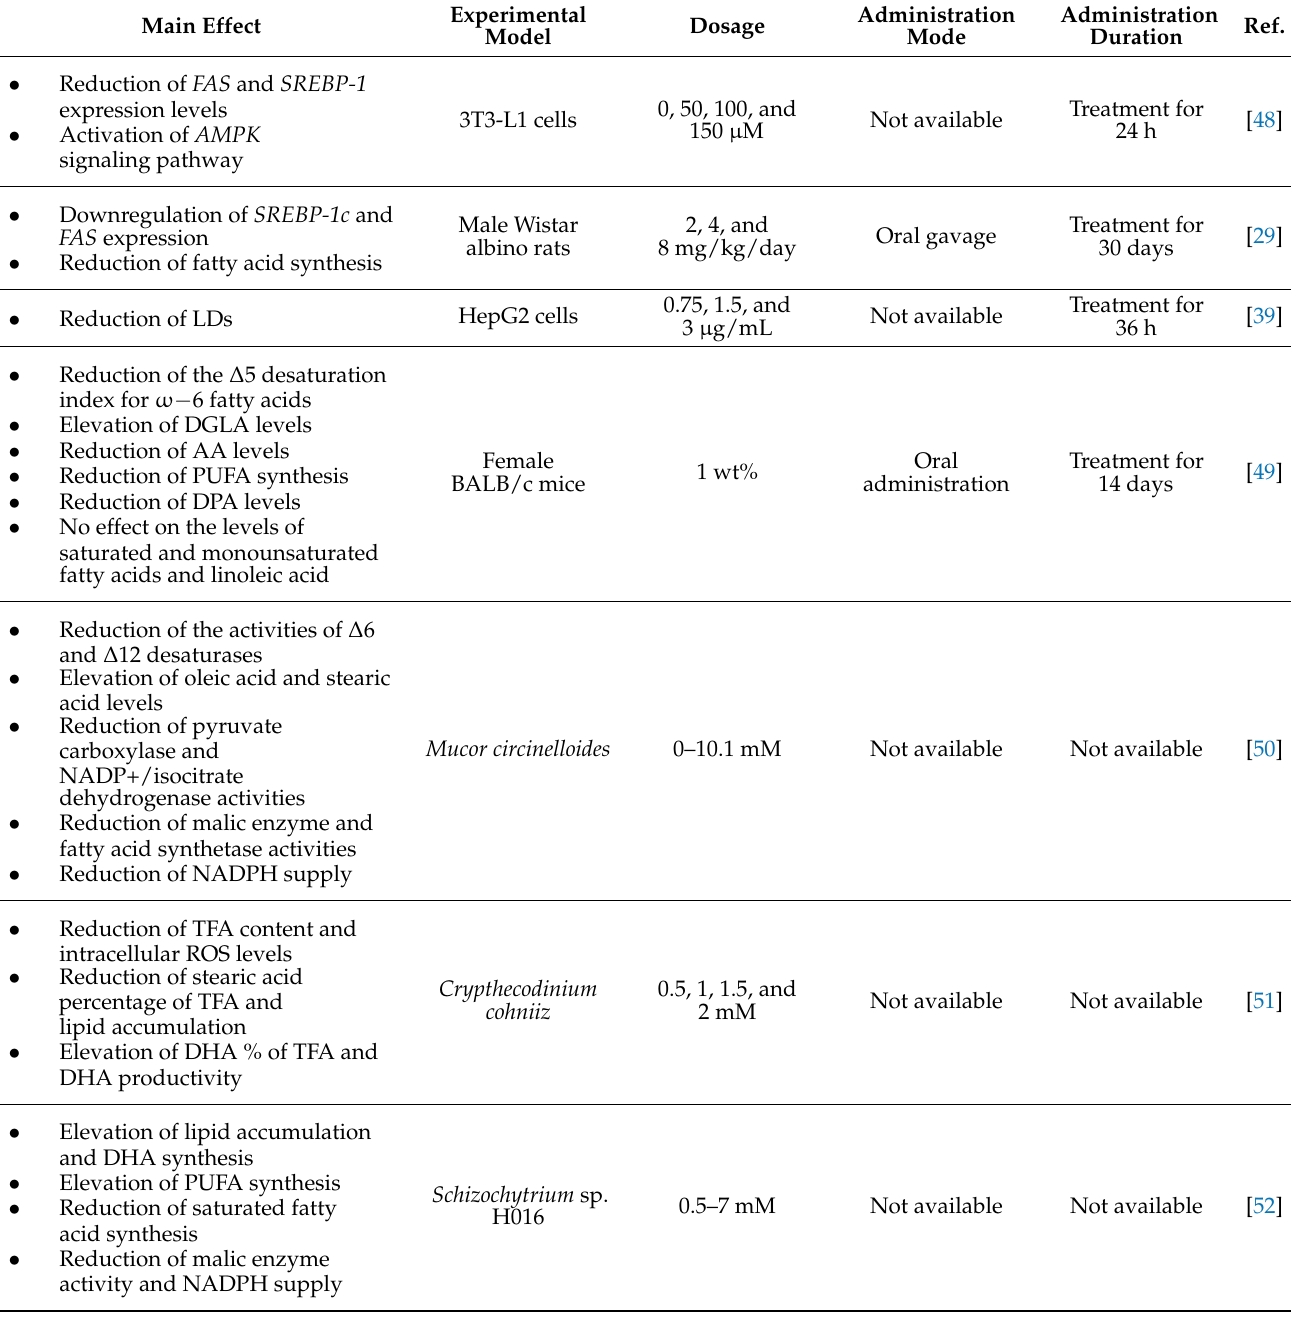
Table 2. The effects of sesamol on fatty acid